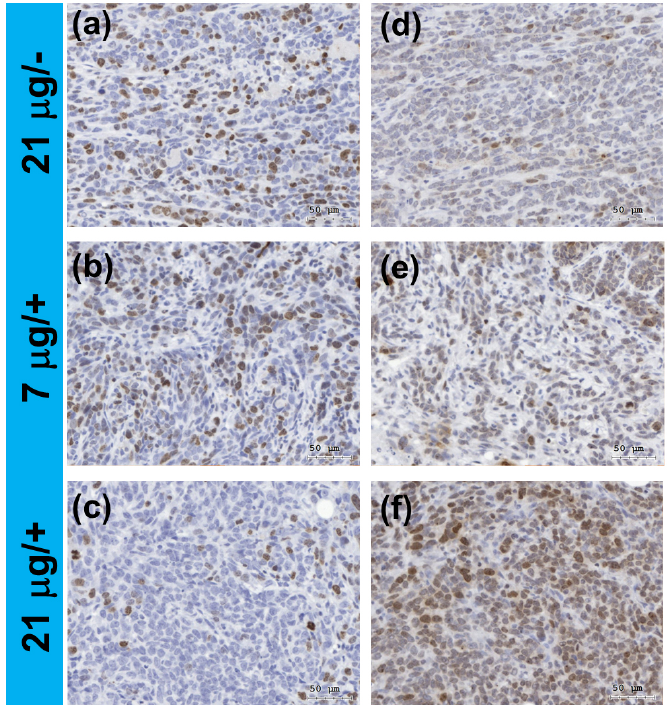
Figure 8. In vivo analysis for a murine 4T1 breast cancer model based on 980-nm laser light-trigged photodynamic therapy (PDT) using the hybrid nanoparticles as the photosensitizer. The tumors were treated with lower (7 µ g) and higher (21 µ g) dosage of the nanoparticles combined with (+) and without ( − ) light exposure. Immunohistochemical analysis of the tissue slices for: ( a – c ) Ki67; and ( d – f ) γ H2AX ser139 , corresponding to the protein markers for cell proliferation and DNA damage, respectively. The brown colors indicated positive staining for the markers. The cell nuclei were counterstained with hematoxylin (blue